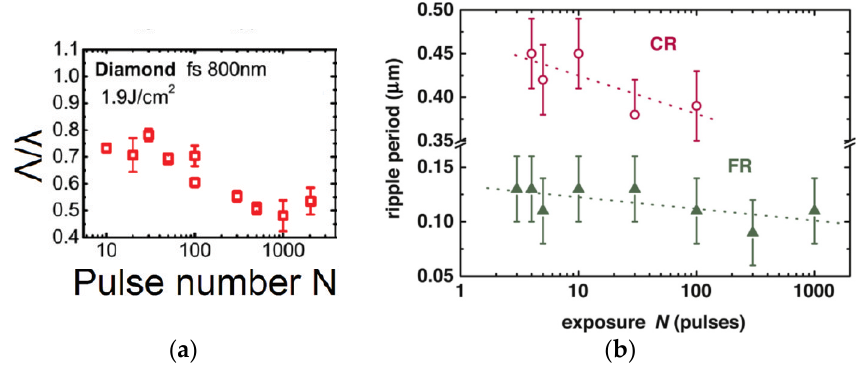
Figure 6. ( a ) Dependence of low spatial frequency (LSF) ripples period normalized to λ as a function of the pulse number N [61] (Copyright 2009 American Chemical Society); ( b ) Dependence of period for LSF (CR—coarse) and high spatial frequency (HSF) (FR—fine) ripples as a function of number N for treatments on diamond with λ = 515 nm [63] (Copyright 2018 Elsevier).